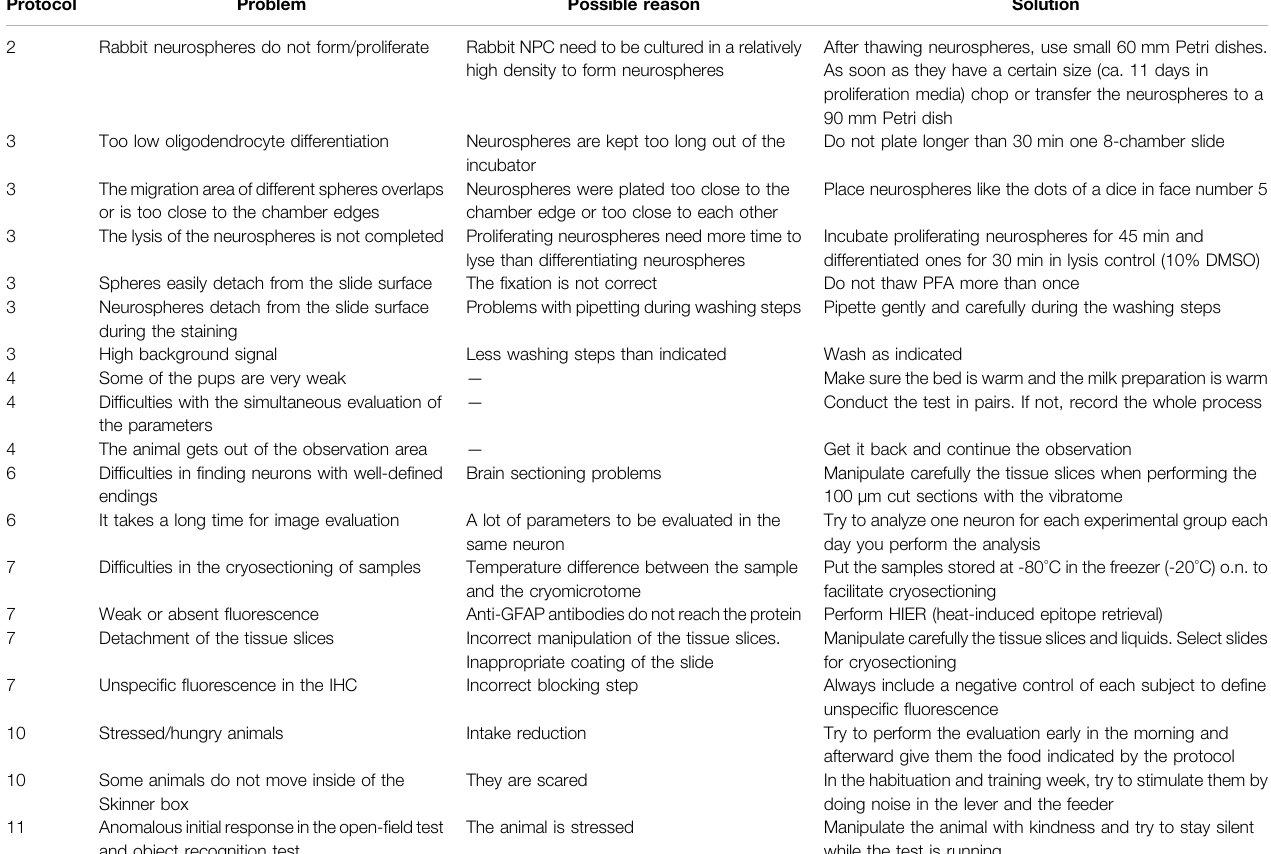
TABLE 2 | General summary of critical parameters and